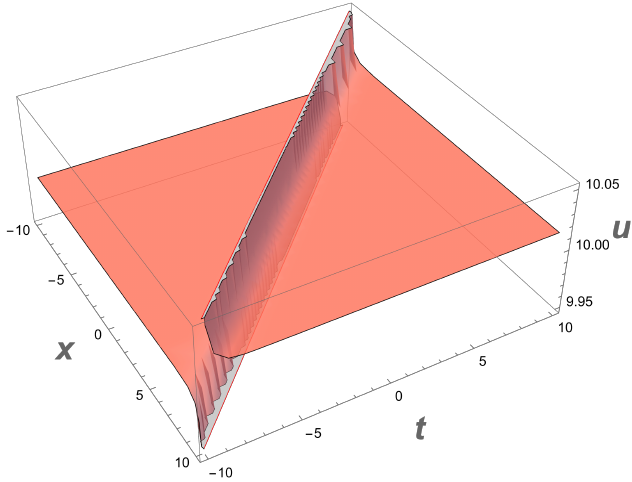
Figure 2. Evolution of the solution of (21) for case 2.